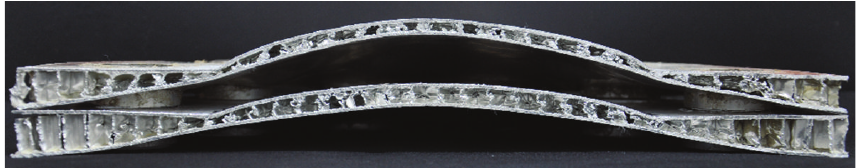
̂𝐼 = 1.147 and the lower panel is the case of